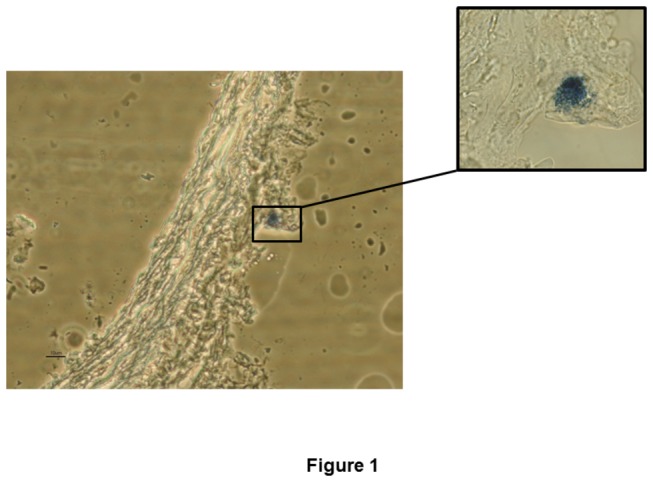
Mast cell localization by toluidine blue staining.Figure is representative of preparations from four rats. Magnification: 400·X and 600 X.